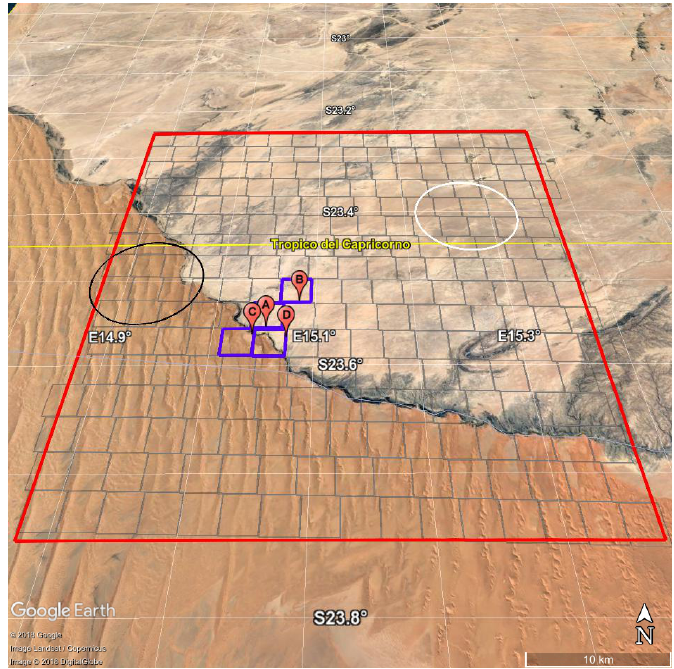
Figure 5. The map shows the target area of this exercise. The red rectangle indicates the SEVIRI target area, whereas the grey line grid-mesh approximates SEVIRI pixels. The red place-marks indicate the position of the ground based measurements and blue rectangles the collocated SEVIRI pixels. White and black circles refers to the IASI footprints used to compare emissivity